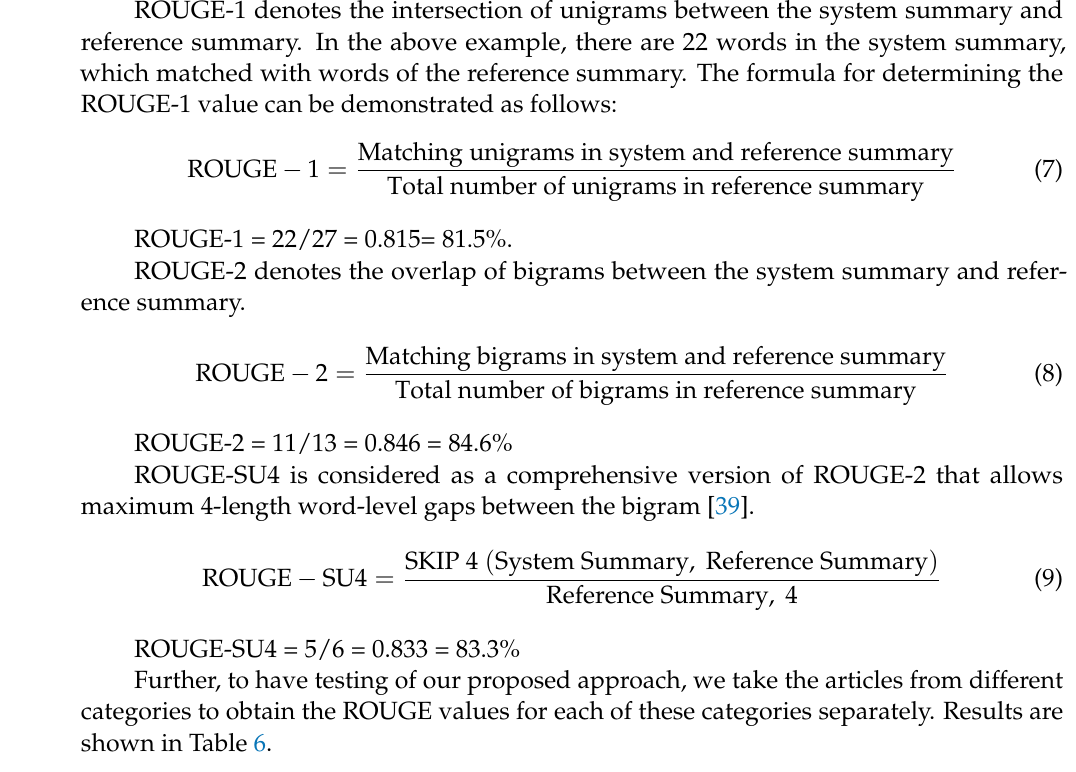
Table 6. All three ROUGE values for different type of